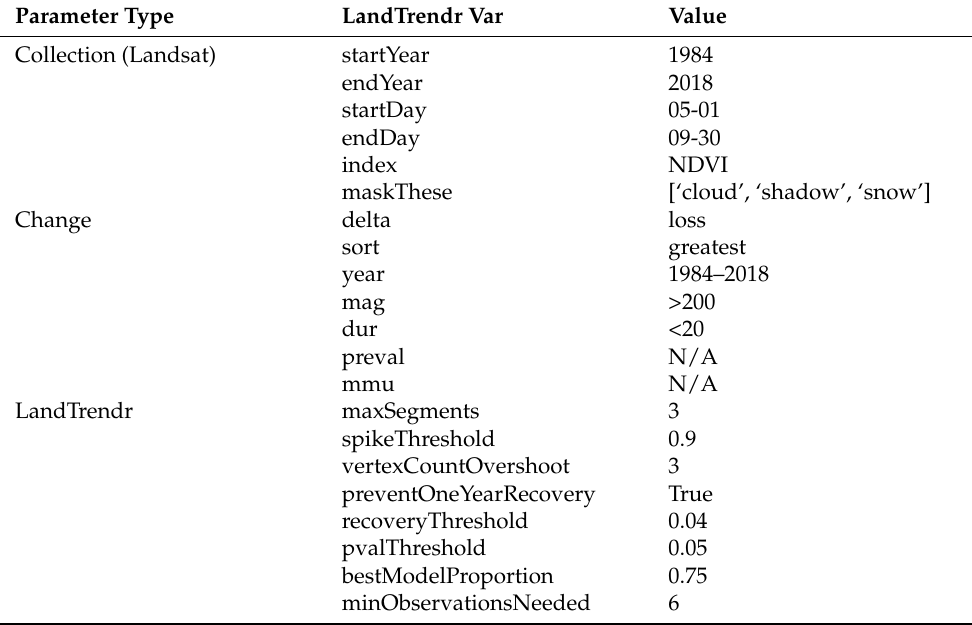
Table A1. Input parameters used in the LandTrendr analysis. Detailed descriptions of input parame- ters can be found in the LandTrendr for Google Earth Engine guide (https://emapr.github.io/LT- GEE/api.html) and in the literature [41].